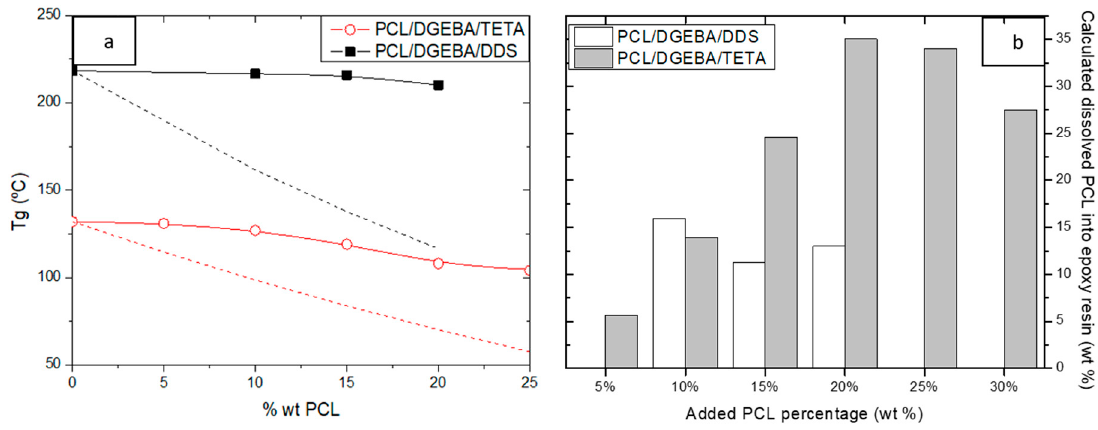
Figure 4. T g of epoxy resin as a function of PCL content added to the blend ( a ). Dot lines are the theoretical T g with total PCL miscibility. Estimated PCL amount dissolved into epoxy resin by the mix´s law ( b